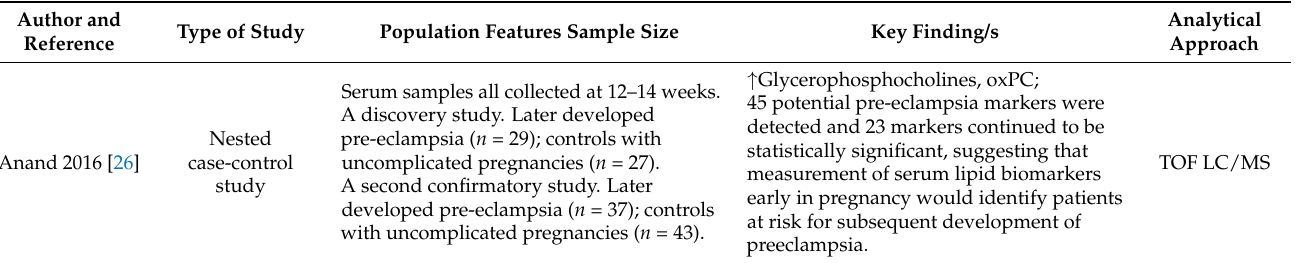
Table 1. Summary of studies on lipid profiling of plasma or serum samples of patients with preeclamp- sia. (“ ↑ ” represents an increase in the level of the metabolite; “ ↓ ” represents a decrease in the level of the